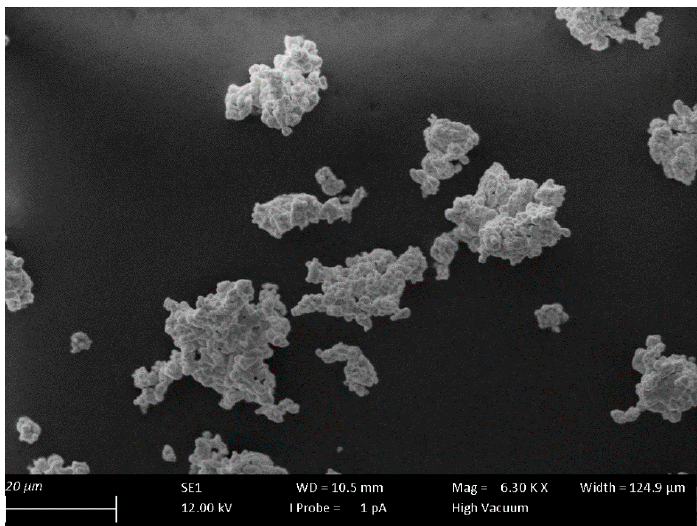
Figure 5. Scanning electron micrograph of (Gd 0.8 Eu 0.2 ) 3 Li 3 (Te 0.99 U 0.01 ) 2 O 12